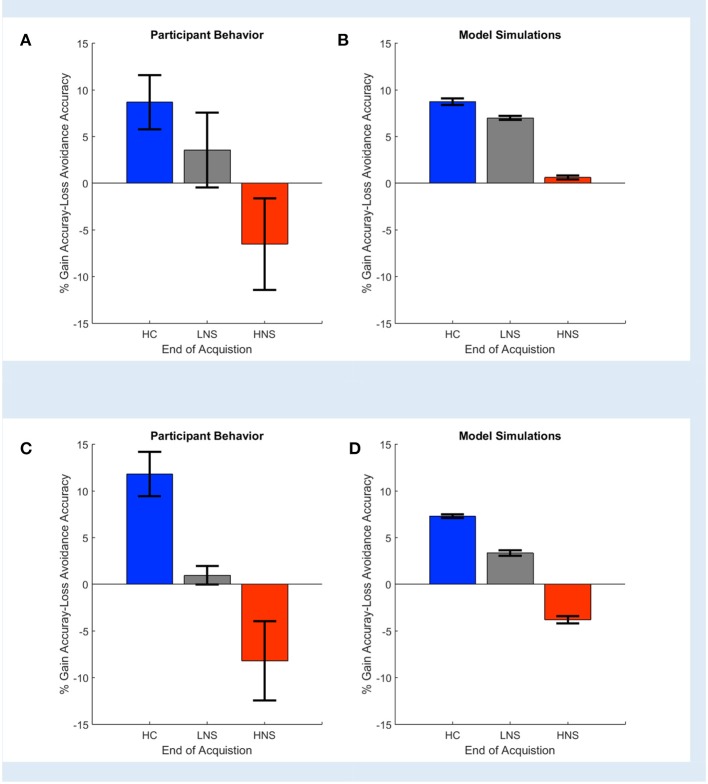
Observed (A,C) and simulated (B,D) end acquisition performance across patient (LNS, HNS) and healthy control (HC) groups. The HC group prefers learning from Gains (reward) rather than learning from avoided losses. This preference is reduced in the LNS group and inverted in the HNS group. The performance (% Gain accuracy—Loss Avoidance accuracy) is defined as the difference between the probability of picking the correct response on Gain trials and the probability of picking the correct response on the Loss Avoidance trials. (A) Observed performance and (B) simulated end of acquisition performance originally reported in Figures 4A,B of Gold et al. (2012). Simulated performance is generated from individual patients' estimated model parameters, as described in the original paper. (C) Observed performance in the dataset shared by Gold et al. and (D) simulated result using an equivalent behavior analysis conducted in COMPASS. For (D), we run the equivalent hybrid model—described in Appendix C in Supplementary Material—per each patient. This gives, for each patient, an estimate (logistic regression coefficient) of the probability of making the correct choice on Gain vs. Loss Avoidance trials. The plot shows the average of these differences for each patient group. The pattern of HC > LNS > HNS on Gain-Loss Avoidance is replicated. Further, COMPASS modeling simulation (D) matches the empirical behavior pattern (C) more closely than the original authors' simulation.